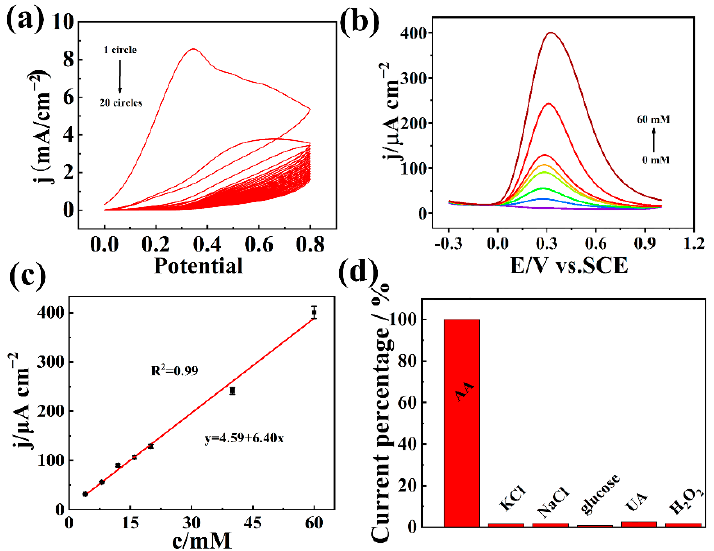
Figure 5. ( a ) CVs of nMIP/AuNPs@COF TFPB-NBPDA during electropolymerization; ( b ) DPV of AA detected by nMIP/AuNPs@COF TFPB-NBPDA /GCE; ( c ) Linear relationship between response current of nMIP/AuNPs@COF TFPB-NBPDA /GCE and AA concentration; ( d ) Diagram of nMIP/AuNPs@ COF TFPB-NBPDA /GCE to different interfering substances.